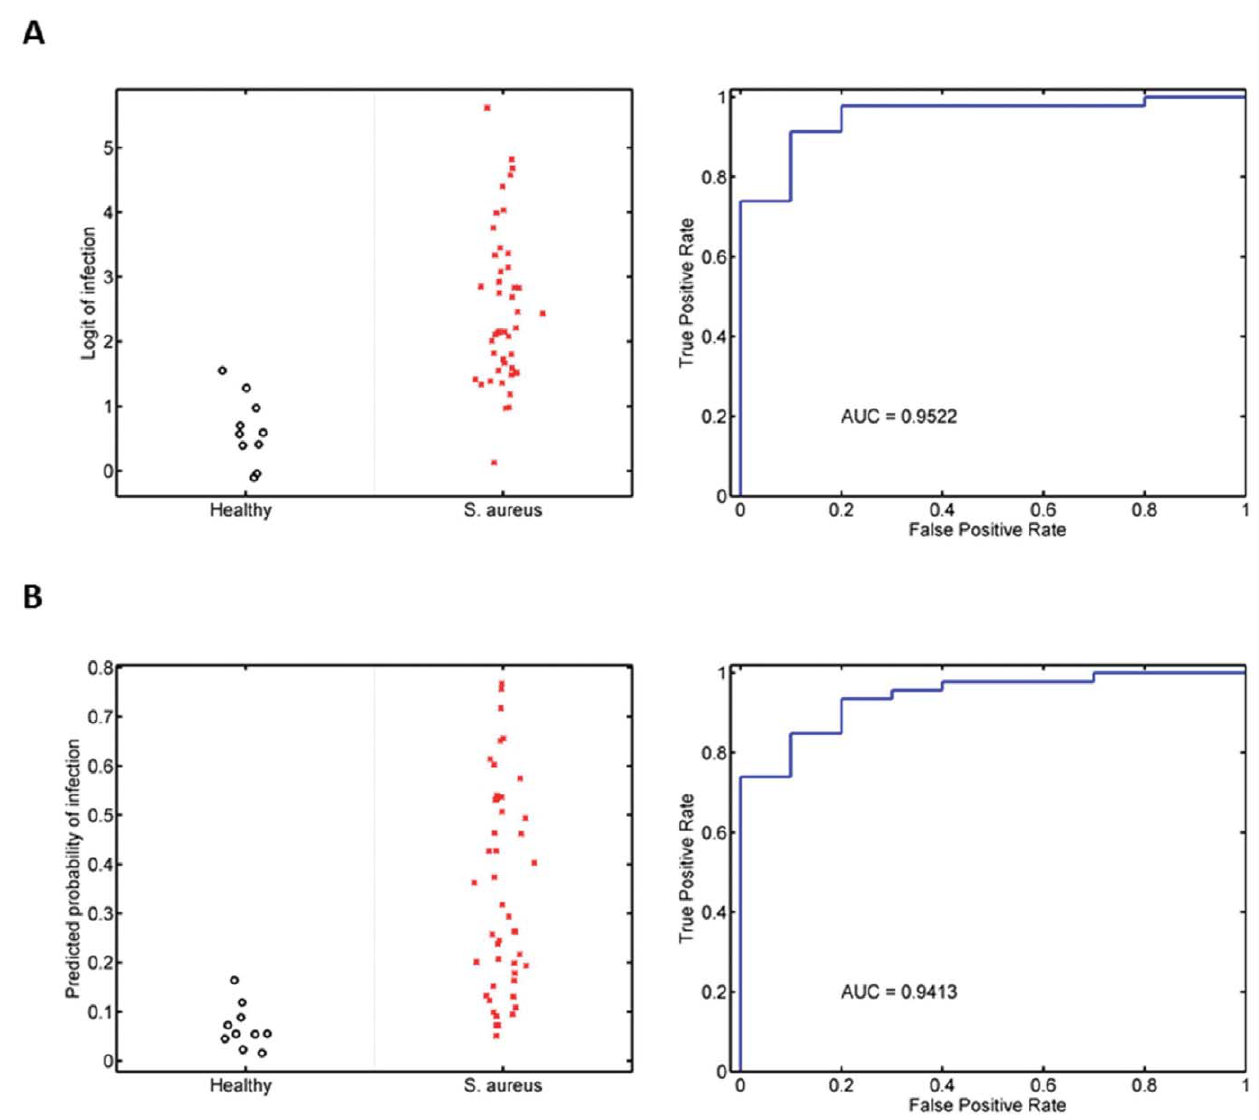
Figure 6. Validation in an independent human cohort [ 18 ] . (A) The murine S. aureus classifier differentiates between S. aureus infection and healthy. (B) The human S. aureus classifier differentiates between S. aureus infection and